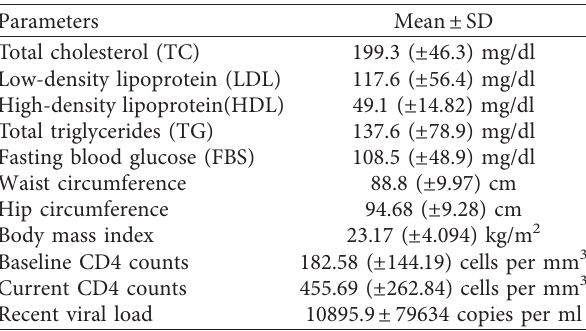
Table 1: Sociodemographic profile of the HIV patients who received ART at armed force comprehensive and specialized hospital, Ethiopia, 2018 ( n � 353).